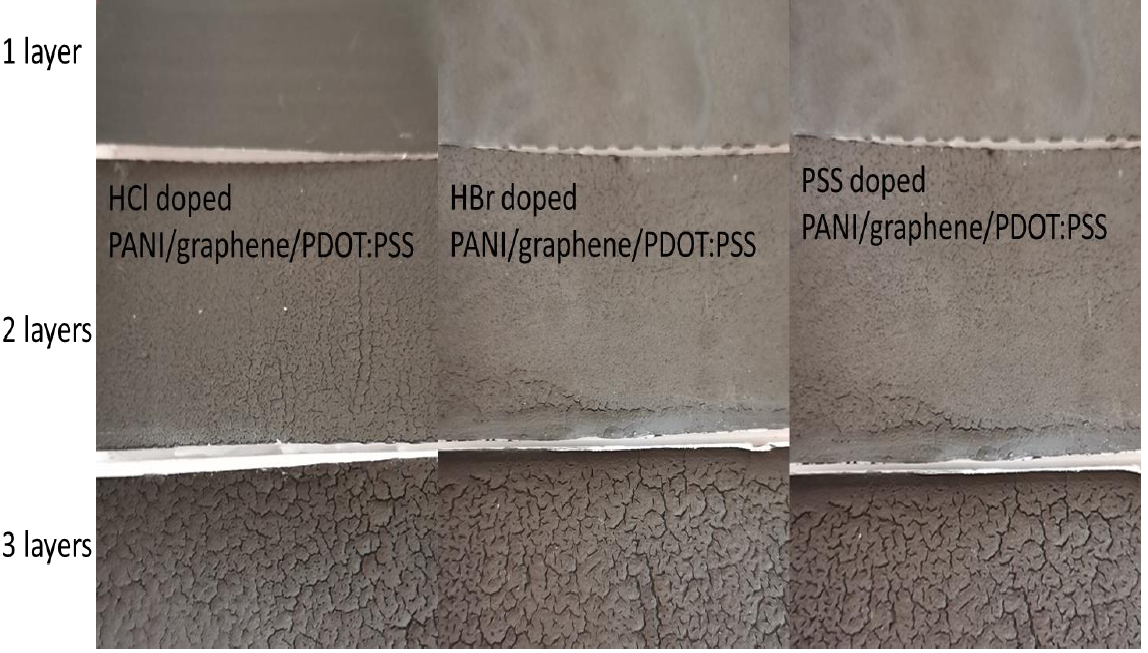
Figure 10. Photos of coatings made with doped PANI/graphene/PEDOT:PSS water-based formula- tions of one, two, and three layers.